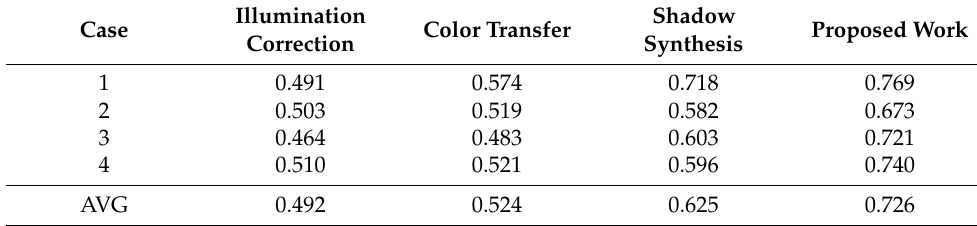
Table 5. Objective evaluation results of gradient similarity